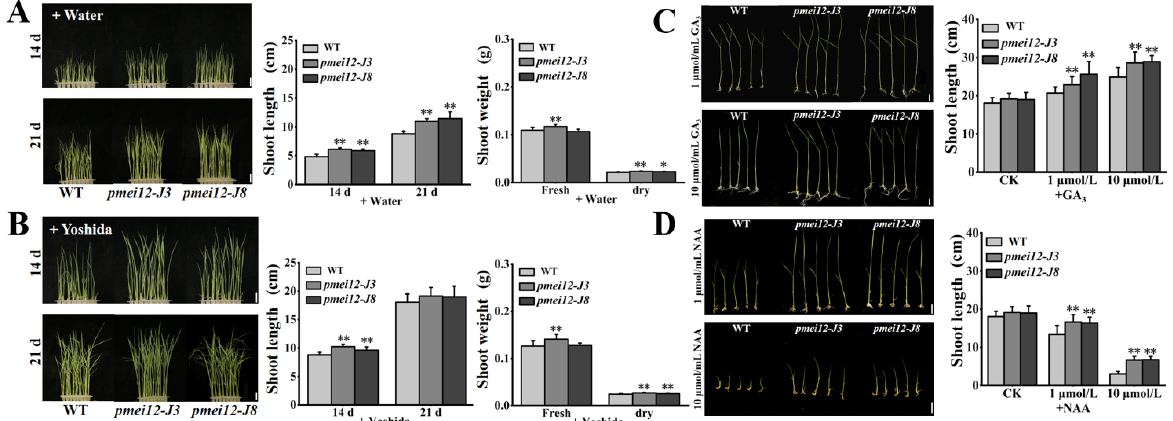
Figure 6. The seedling of pmei12 lines and WT under Yoshida nutrient solution and under phytohormone treatments. ( A ) Seedlings of WT and pmei12 lines + Water; ( B ) Seedlings of WT and pmei12 lines + Yoshida; ( C ) Seedling growth with GA 3 (1 µmol/L and 10 µmol/L); ( D ) Seedling growth with NAA (1 µmol/L and 10 µmol/L). * and ** indicate the significant differences between pmei12 lines and WT by t -test at p < 0.05 and 0.01, respectively. Scale bars: ( A , B ) 2 cm, (n = 30); ( C , D ) 1 cm, (n = 30).